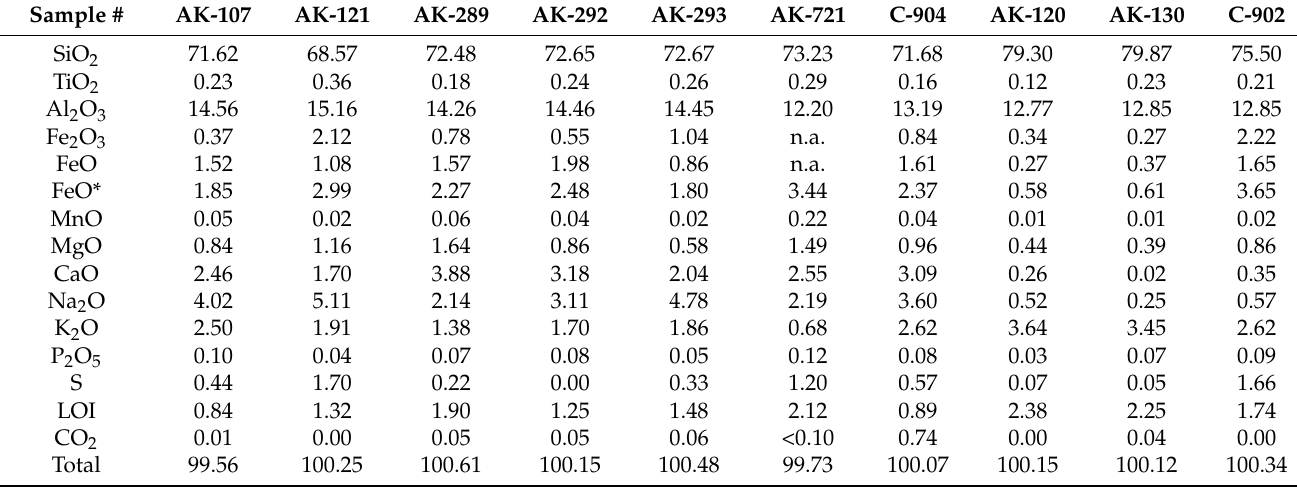
Table 1. Chemical composition (wt%) of granite porphyry and altered rocks of the Pellapahk intrusion.